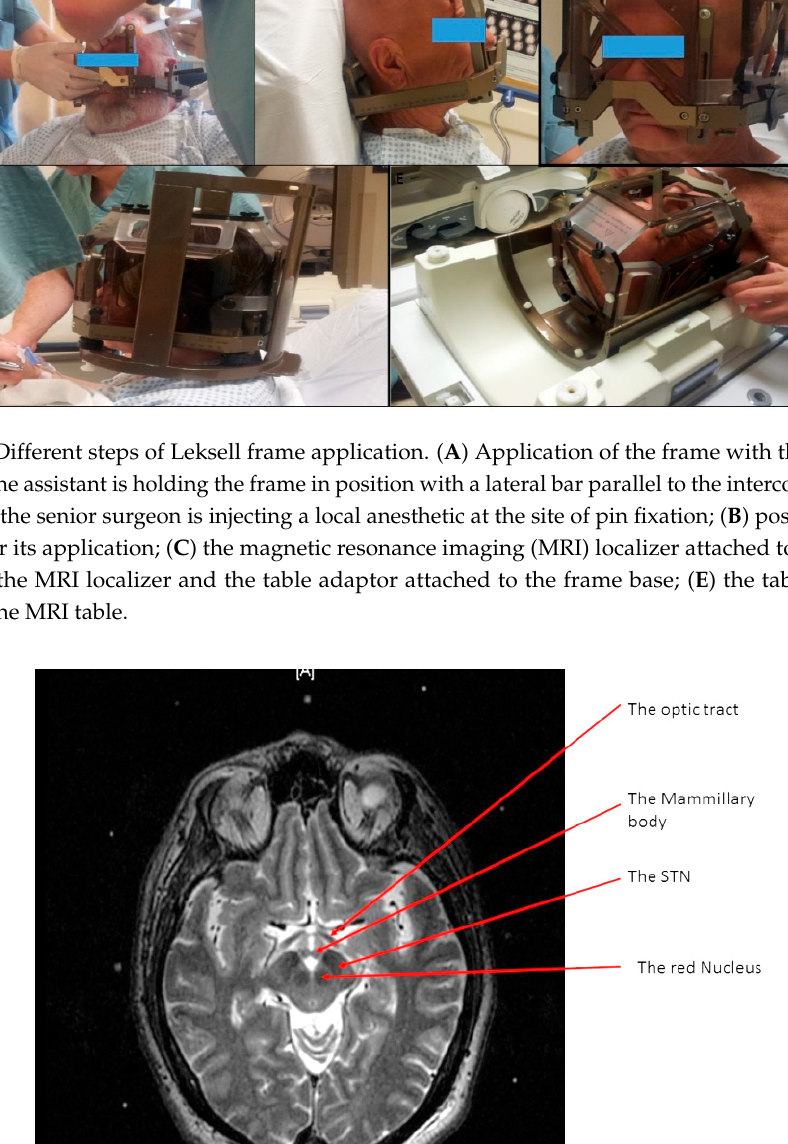
Figure 2. An axial T2 weighted magnetic resonance imaging (MRI) image at the level of the subthalamic nuclei (STN).